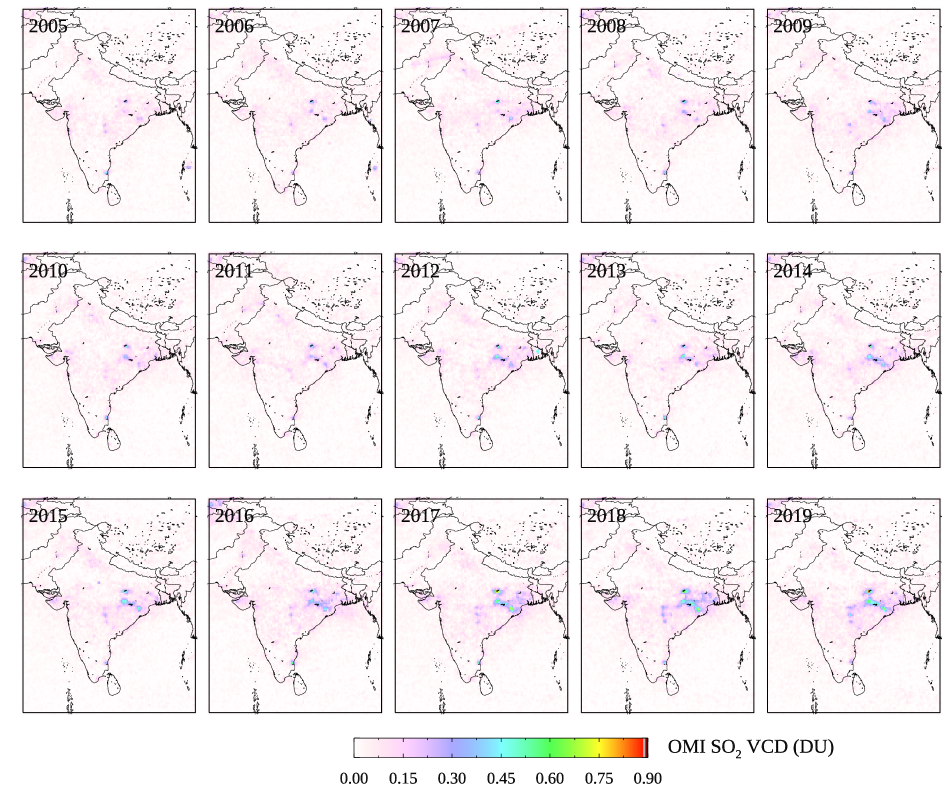
Figure 9. Same as Fig. 8 but for